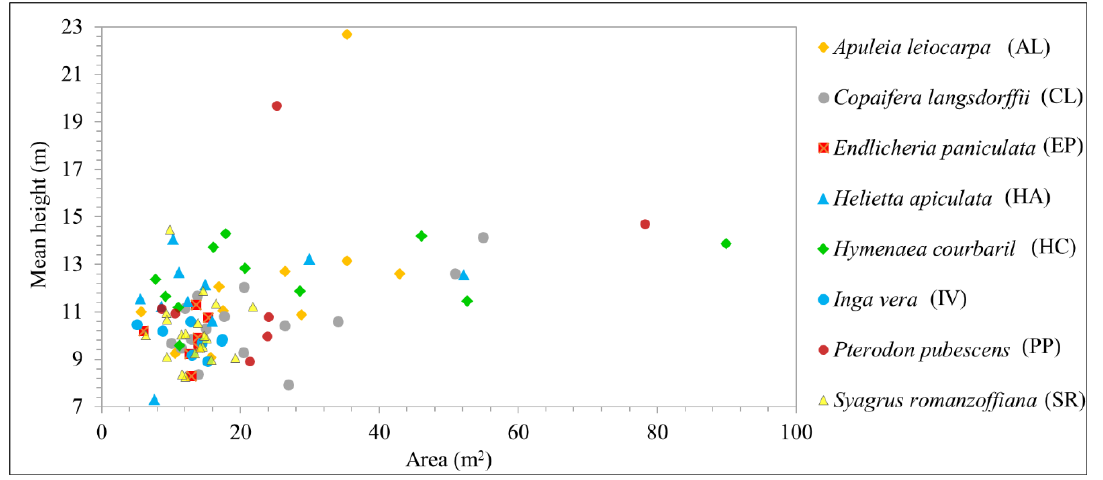
Figure 5. Mean tree height versus the tree crown area for all samples identified in the field. Data are from the 2017 dataset.